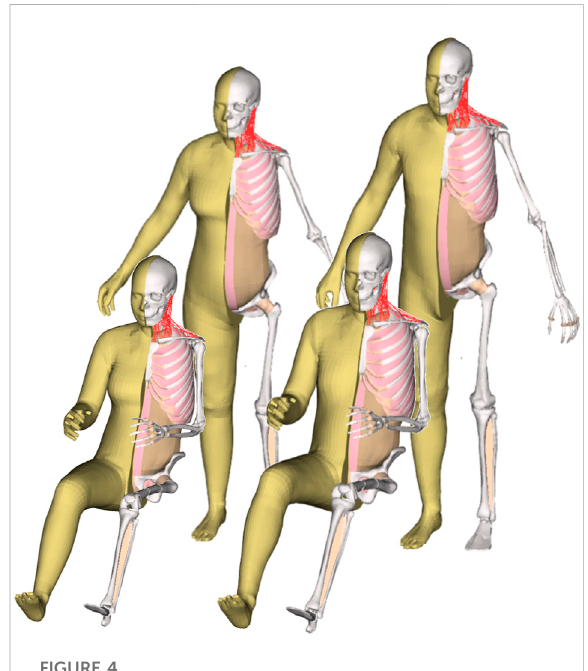
FIGURE 4 The VIVA + model lineup: the base model of the average female with the derivative male and corresponding standing